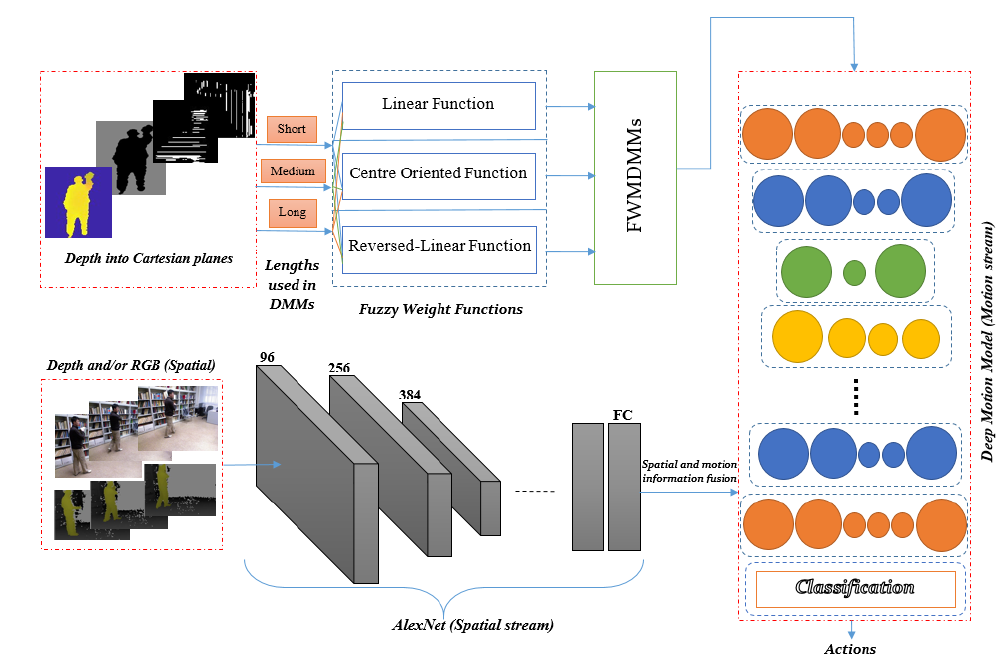
Figure 1. Framework of the proposed